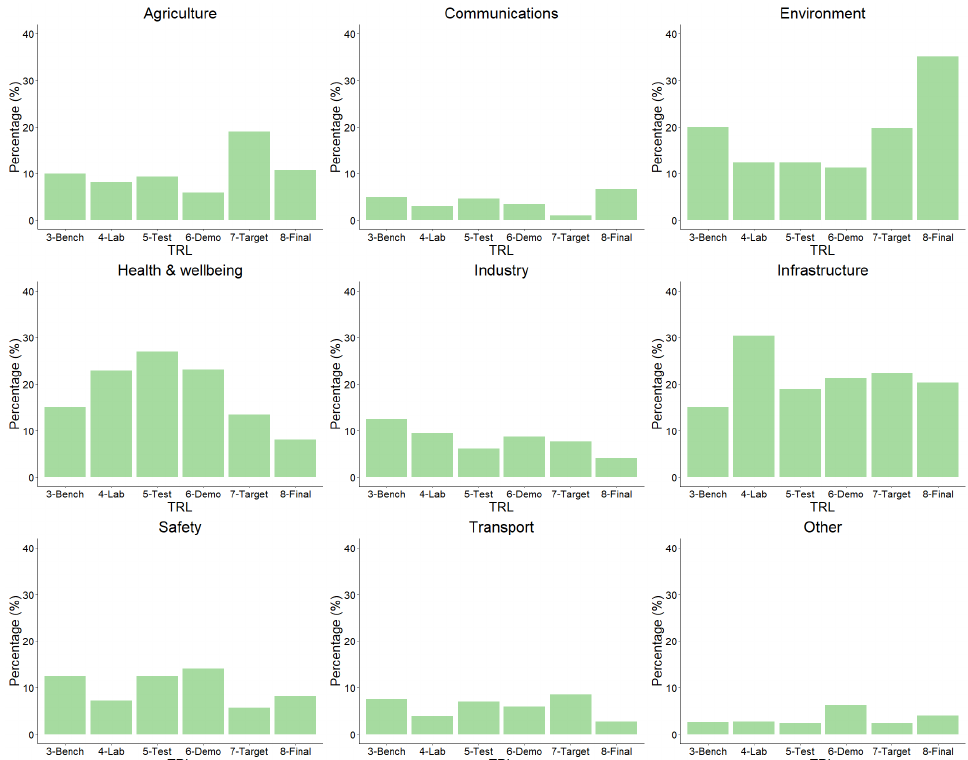
Figure 10. Deployment distribution between TRL and field of the goal network. Inverted grouping of TRL and goal network show that main target of deployments without field of the goal network (e.g., pure research) is focused on TRL4 and TRL5, as shown in Figure 11. Significant amount of deployments for infrastructure, environment and agriculture are focused on TRL7.